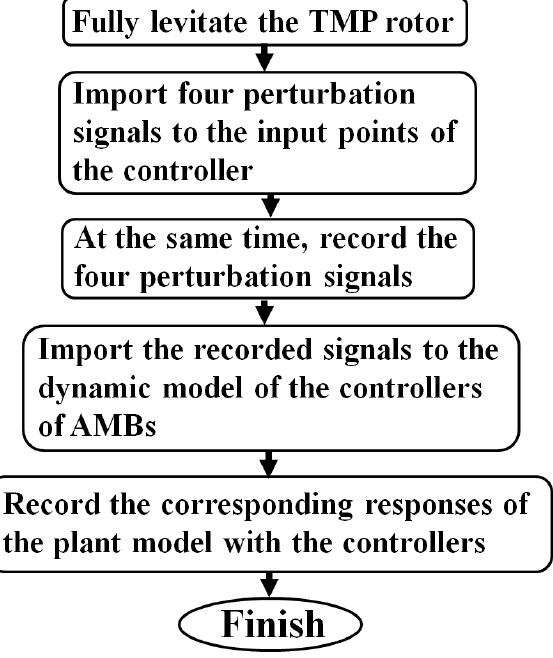
Figure 2. Identification procedure of controller.